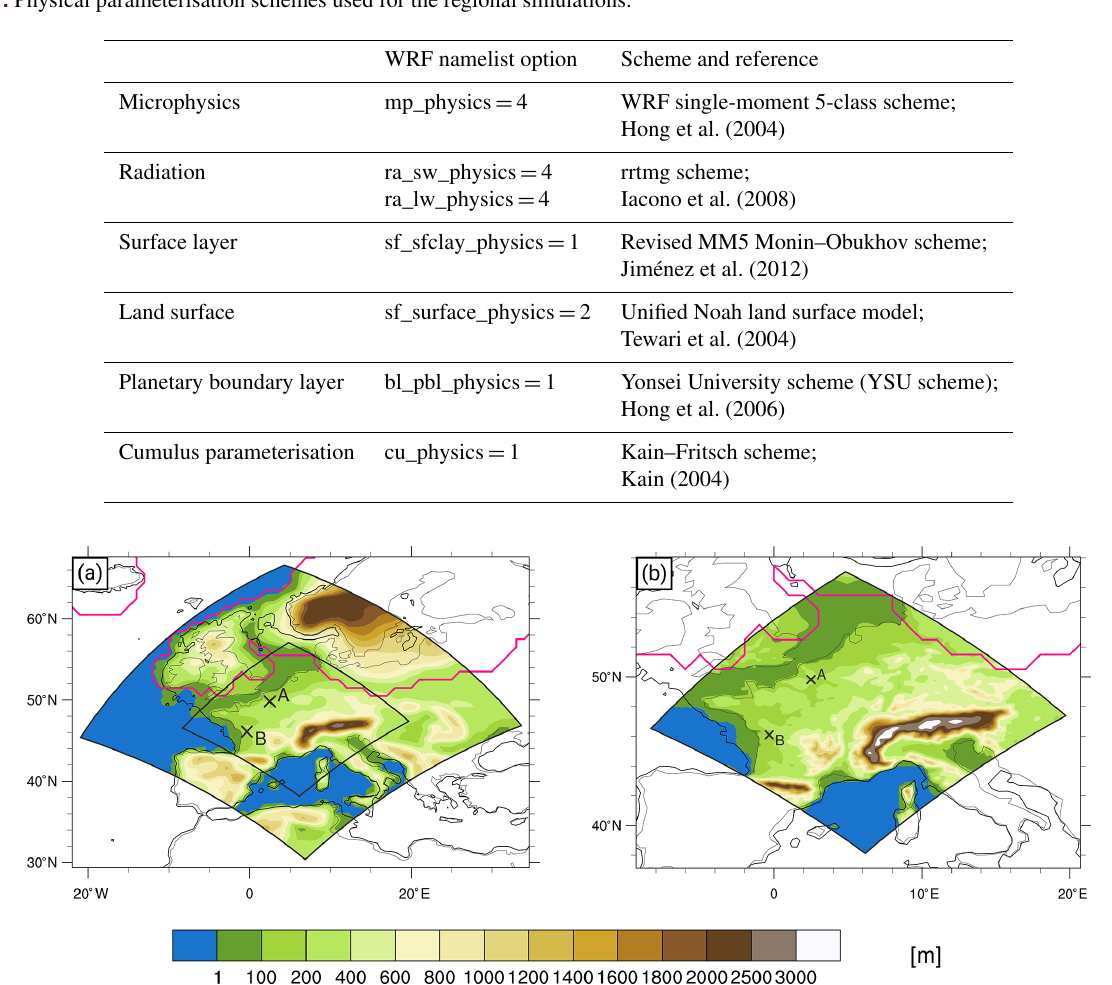
Figure 1. WRF model domain orography with the LGM coastline (black line) and LGM ice sheet (pink line). (a) Domain 1 with 50km grid spacing; (b) domain 2 with 12.5km grid spacing. Locations A and B on the map refer to the time series of soil temperatures and soil temperature gradients shown in Fig. 7 and Fig. S6 in the